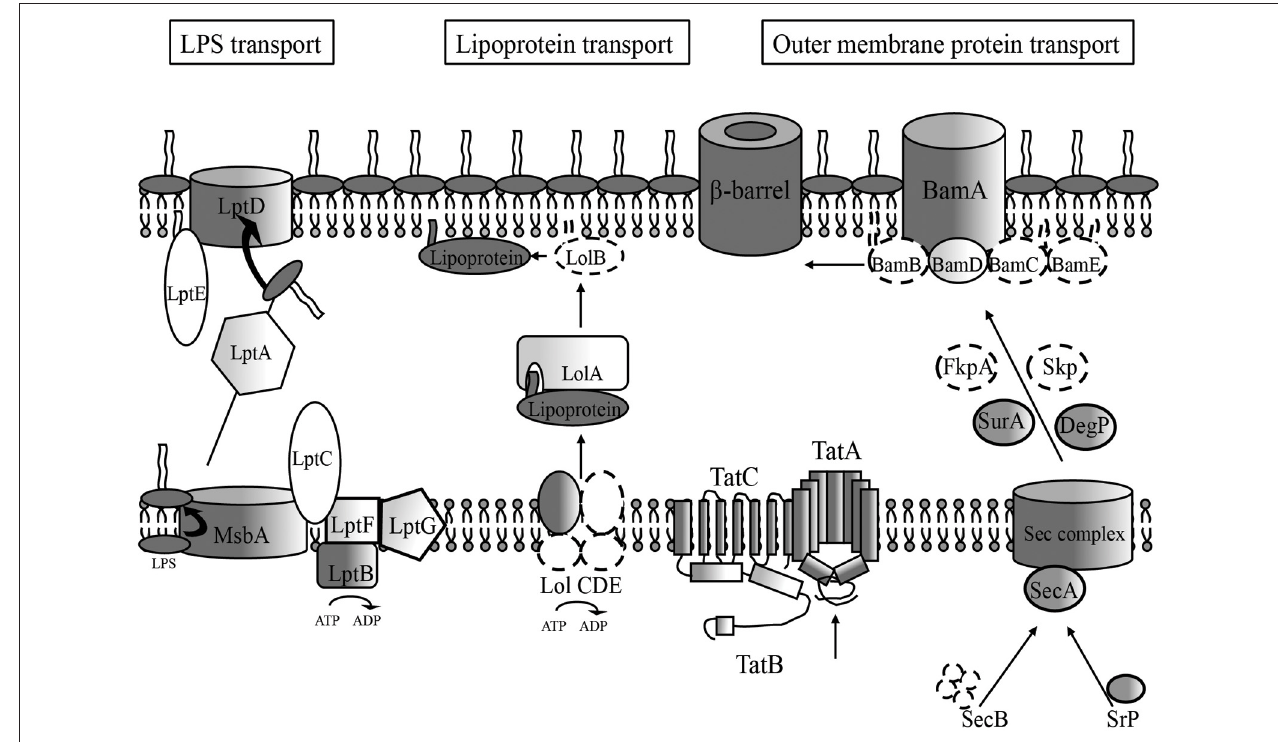
FIGURE 1 | Membrane biogenesis pathway conserved features in H. pylori . Dark features indicate high similarity scores ( ≤ e 4 ) for H. pylori genes compared to E. coli outer membrane biogenesis pathway components, which generally consist of the IM and OM spanning portions of the pathway. Lighter shaded components indicate lower similarity scores requiring comparison of numerous bacterial homologs before attaining a significant similarity score ( ≤ e 4 ) for an H. pylori locus. An absence of shading indicates no homolog for that component was found through sequence similarity scores, but the existence of a